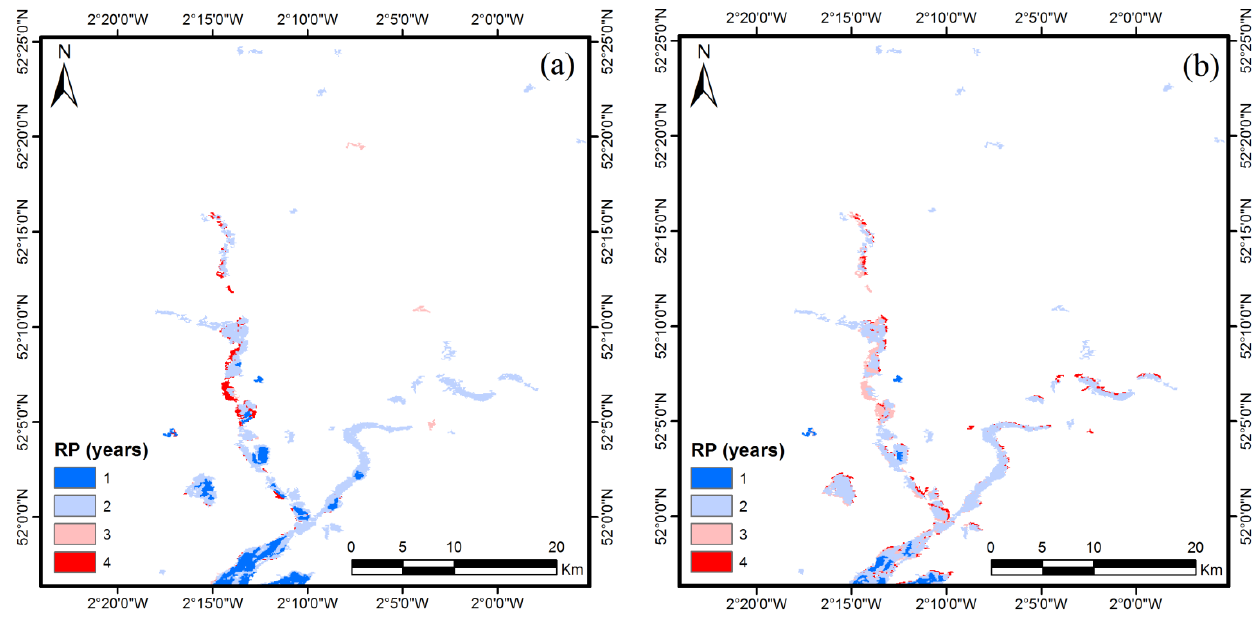
Figure 8. Hazard maps: ( a ) HM FE with probabilities estimated through FE PDWC2012 and ( b ) HM GDF with probabilities estimated through GDF at Haw